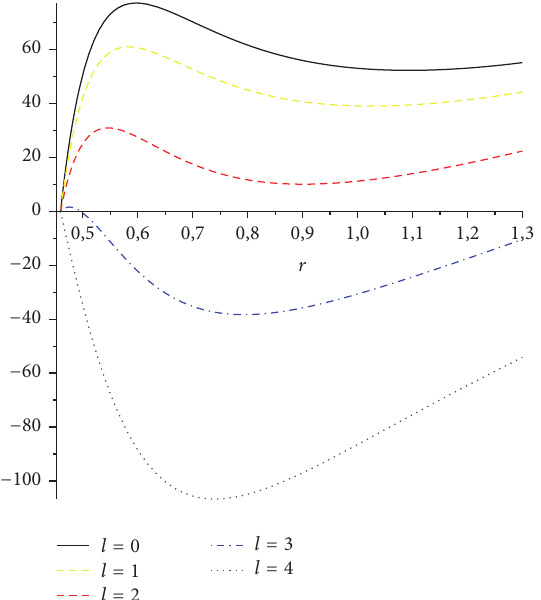
Figure 1: The potential 𝑉 in function of the radius for values 𝑙 = 0 (solid thick line), 𝑙 = 1 (long-dashed line), 𝑙 = 2 (dashed line), 𝑙 = 3 (dot-dashed line), and 𝑙 = 4 (dotted line) for the fixed values of 𝛼 0 = 0.677 , 𝑀 = 1 , and 𝜇 = 0 .